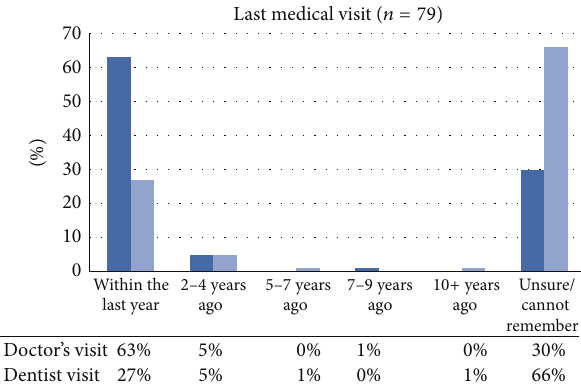
Figure 1: Intervention healthcare access and